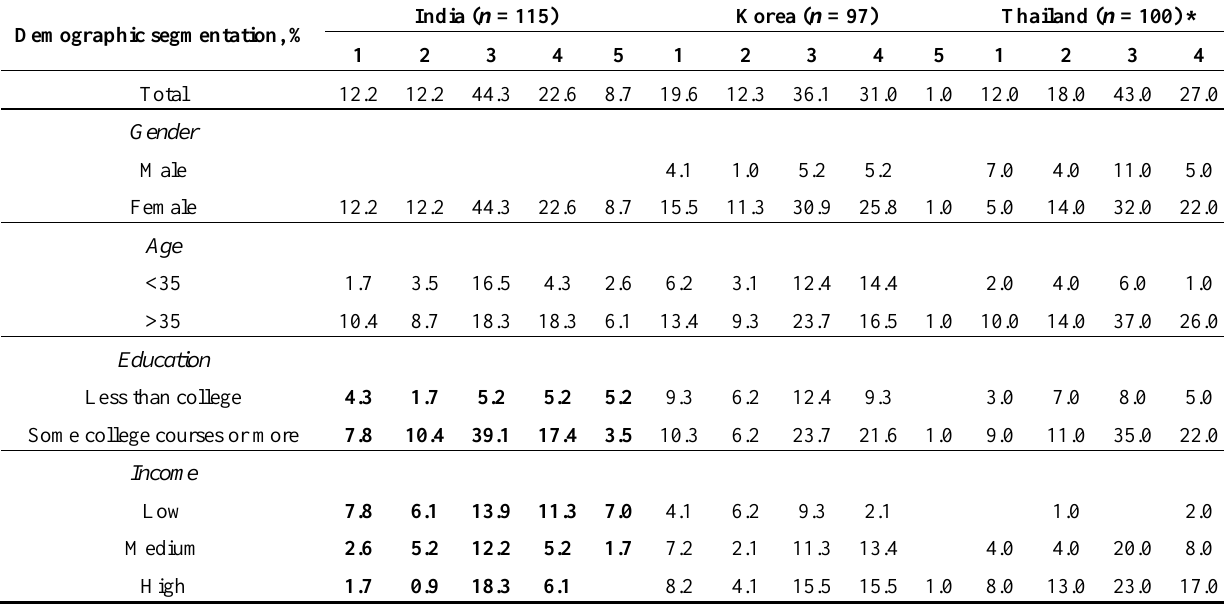
Table 8. Consumers’ practices related to the use of cutting boards. When you are cutting various types of food such as meat, vegetables, eggs, bread, do you usually use: (Select one). Available options included: The same cutting surface (counter, plate, cutting board) and wipe or wash it at the end (1); The same cutting surface (counter, plate, cutting board) and wipe it between uses (2); The same cutting surface (counter, plate, cutting board) and wash it between uses (3); A different cutting surface for each type of food (4); Do not use a cutting surface